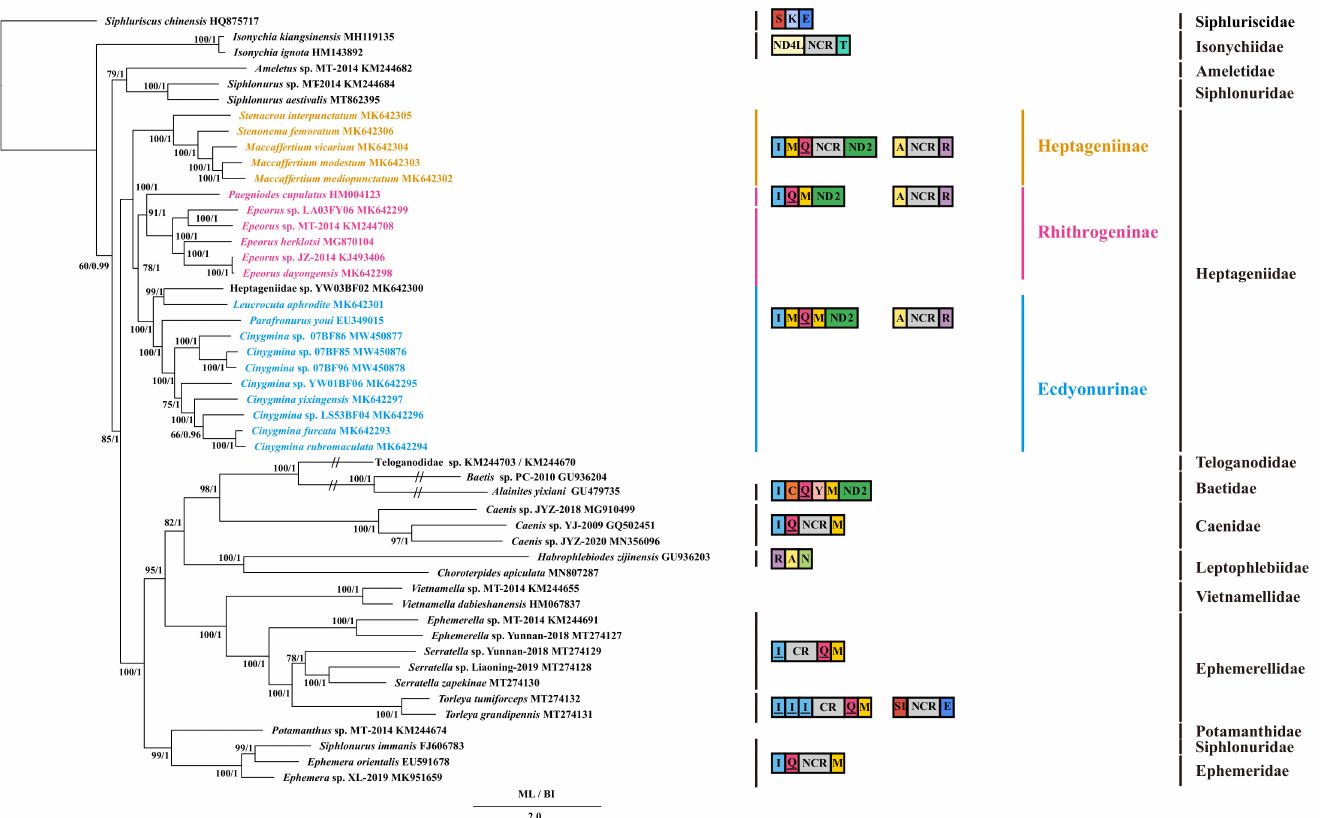
Figure 3. Phylogenetic tree of the relationships among 49 species of Ephemeroptera according to the nucleotide dataset of the 13 mitochondrial PCGs. Siphluriscus chinensis was used as the outgroup. The numbers above branches specify bootstrap percentages from ML ( left ) and posterior probabilities as determined from BI ( right ). The GenBank accession numbers of all species are shown in the figure. Box images on the right show gene rearrangements and the location of the NCR for the various mayfly species. Genes encoded by the minority strand are underlined, and those without underline are encoded by the majority strand. Different colored boxes represent different genes. The remaining genes and gene orders that were identical to the ancestral insect are left out. Gene sizes are not drawn to scale. The asterisks ( * ) by Siphlonuridae on the far-right side denote the separation of these